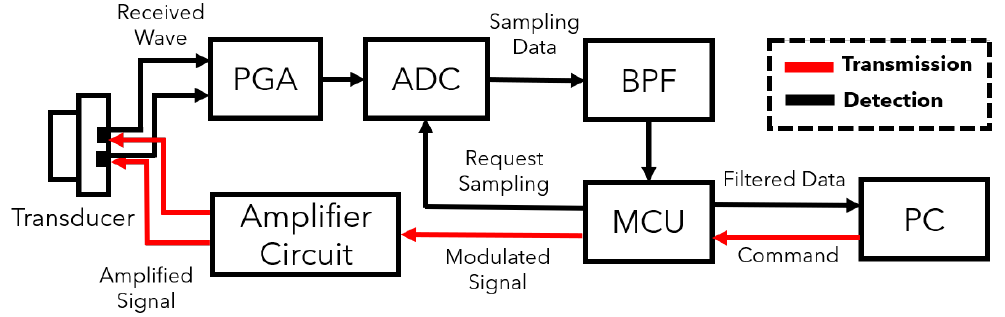
Figure 6. Block diagram of the ultrasonic